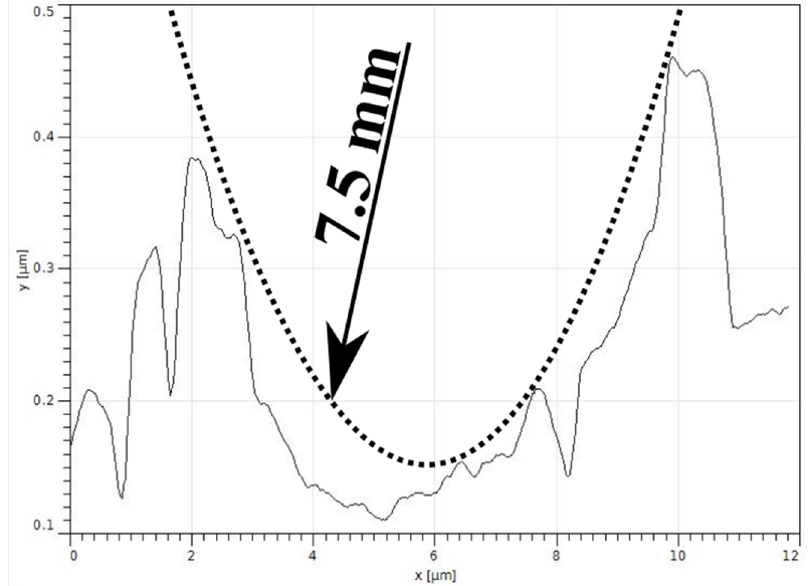
Figure 6. AFM pictures of Degulor M surface after modification. A worn rift of about 15 um in width (area A), aggregation of worn material (area B), and unmodified material (area C). In the cross-section, an approximate shape of the zirconium oxide sphere probe intending the specimen is presented.